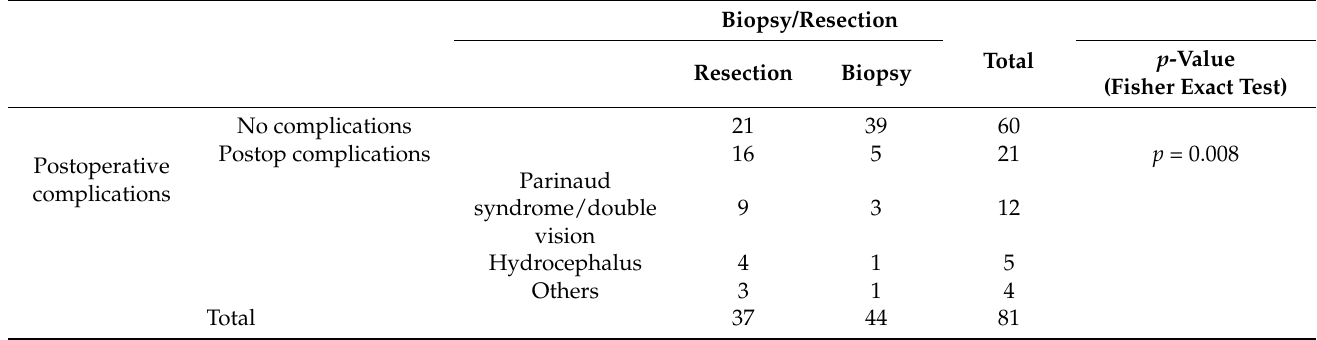
Table 3. Postoperative complications (biopsy vs. resection). A total of 37/57 patients in resection group and 44/54 patients in biopsy group had complete documentation regarding postoperative complications; the others were excluded from this statistical analysis. There was a significant lower risk of postoperative complications in the biopsy group of the documented patients ( p -value = 0.008).